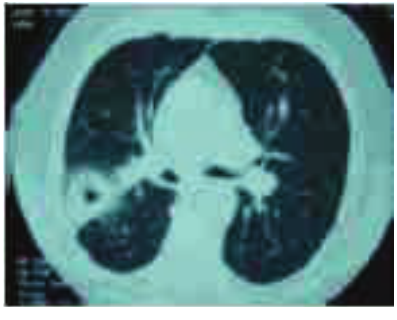
Figure 1. Computed tomography-scan of the chest shows a cavitary lesion in the right upper lobe.